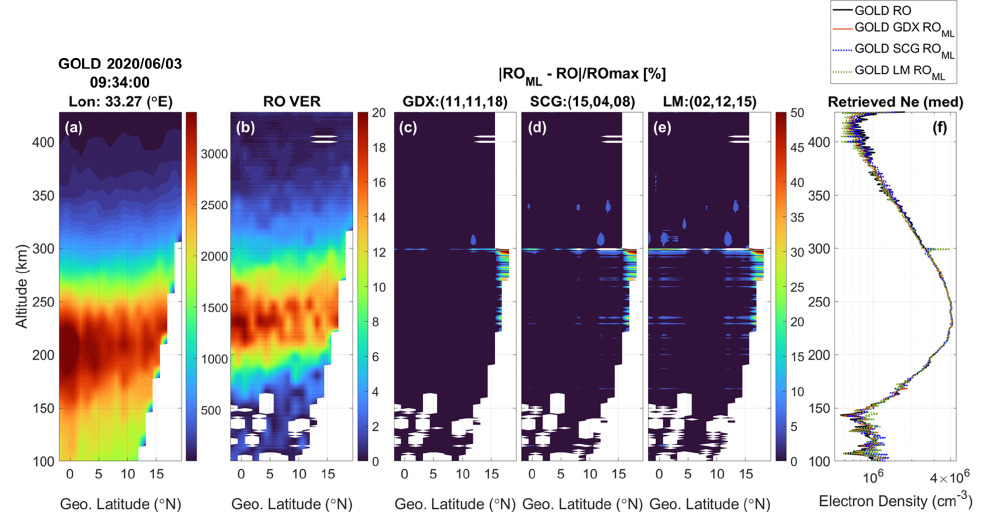
Figure 11. Results from a single instance (3 June 2022 09:34 UT as an example) of GOLD limb 135.6 nm emission intensity RO and ML-RO retrieved VERs, and the photochemical model inverted median Ne from VERs. The vertical and horizontal axes indicate the tangent altitude and geographic latitude ( ◦ N), respectively. ( a ) GOLD 135.6 nm limb intensity profiles (unit: Rayleigh); ( b ) GOLD RO-VER profiles; The difference of ML RO-VER ( RO ML ) and GOLD RO-VER ( RO ) divided by the GOLD RO-VER maximum in each profile ( RO max ): | RO ML − RO | / RO max by using nets ( c ) GDX: (11, 11, 18), ( d ) SCG: (15, 04, 08), and ( e ) LM: (02, 12, 15); ( f ) The inverted median Ne profiles from RO ML -VER by GDX: (11, 11, 18) (red), SCG: (15, 04, 08) (blue), LM: (02, 12, 15) (green), and GOLD RO-VER